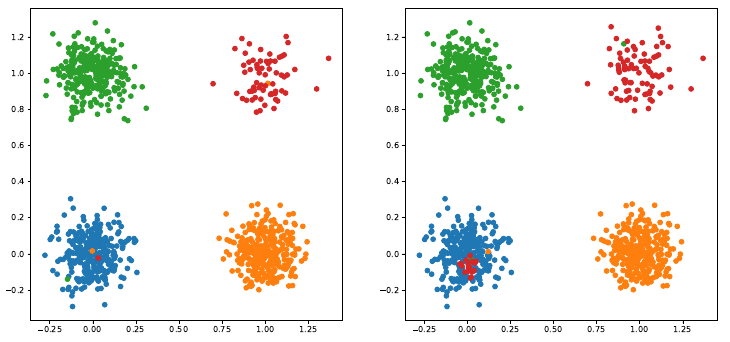
Figure 2. Example of instances from the first dataset, classified by HPFuzzNDA (the left graph) and by PFuzzND (the right graph) algorithms. Red points belong to the novel